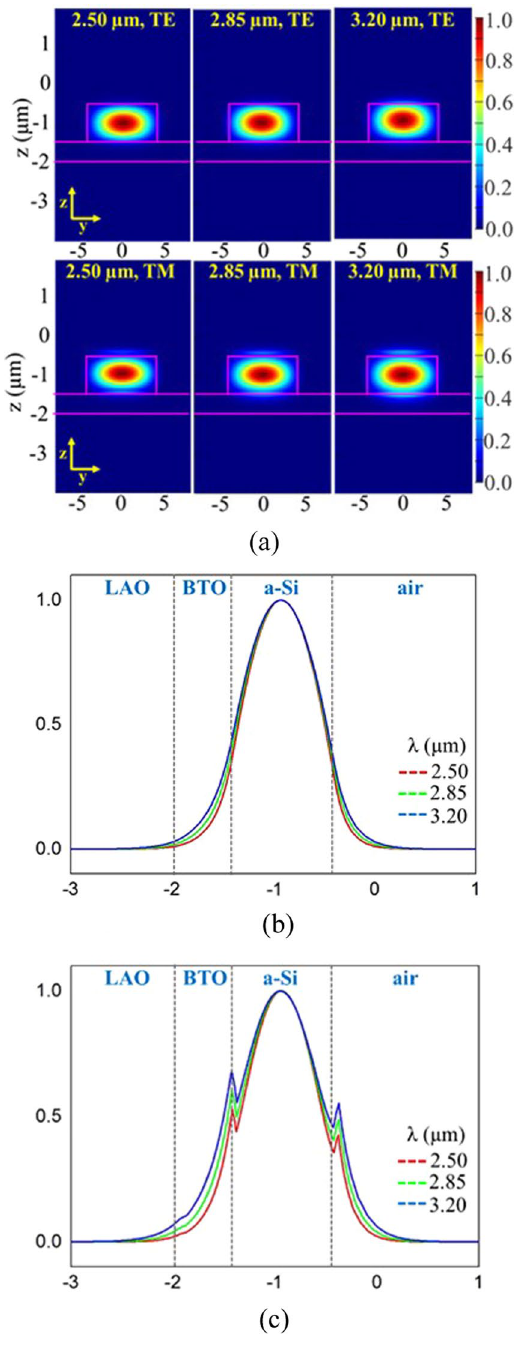
Figure 2. ( a ) The optical fields of the mid-IR waveguide were calculated at λ = 2.50 µ m, 2.85 µ m, and 3.20 µ m. Fundamental modes with similar ellipsoid intensity distributions were resolved in the Si layer in all three wavelengths. ( b ) and ( c ) are the calculated 1D intensity profiles of the TE modes and the TM modes, along the z axis,